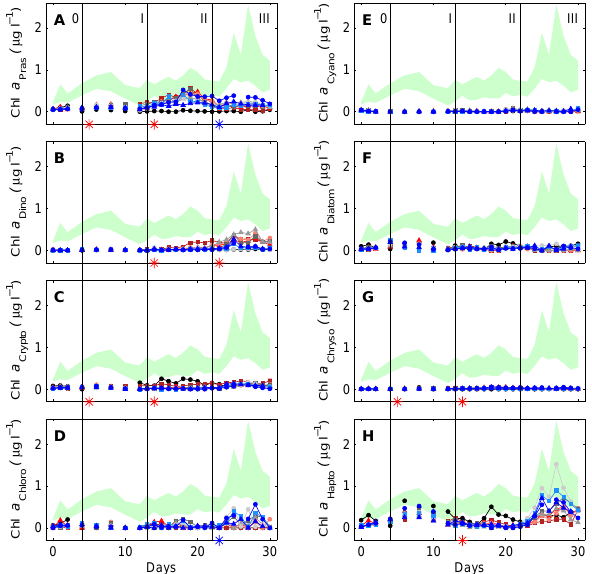
Fig. 10. Temporal development of depth-averaged (0.3–12m) Chl a equivalent concentrations of prasinophytes (A) , dinoflagellates (B) , cryptophytes (C) , chlorophytes (D) , cyanobacteria (E) , diatoms (F) , chrysophytes (G) and haptophytes (H) as analysed by HPLC and CHEMTAX (see Materials and Methods section for details). Green shaded area illustrates minima and maxima of total Chl a concen- trations in the mesocosms. Style and colour code follow those of Fig. 6, and statistical results are summarized in Table